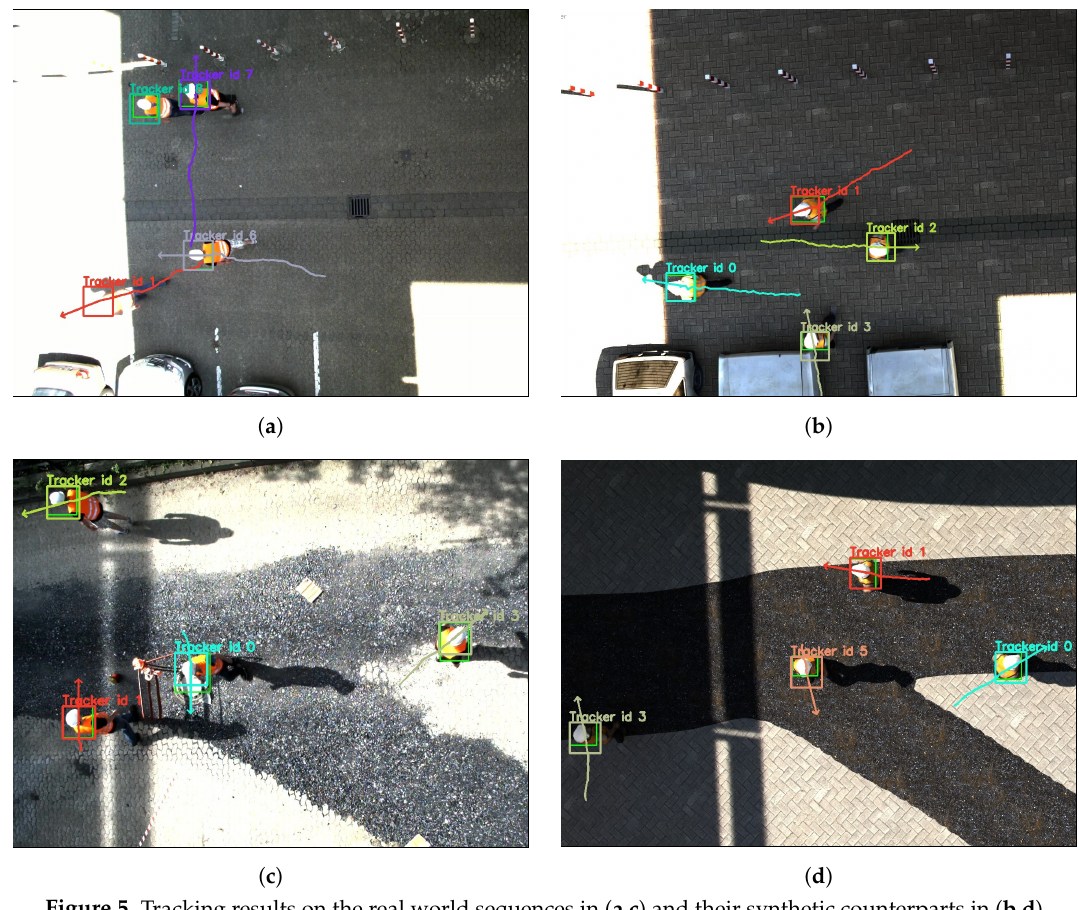
Figure 5. Tracking results on the real world sequences in ( a , c ) and their synthetic counterparts in ( b , d ). Ground truth labels are marked as green rectangles whereas differently colored rectangles illustrate tracked workers’ positions. Each worker’s trajectory is represented by a colored line and the prospective movement is depicted as a colored arrow. Table 2. Comparison of our system’s tracking performance on the first scene from our real dataset and its synthetic counterpart. IDs are assigned randomly and correspond to a single tracked worker